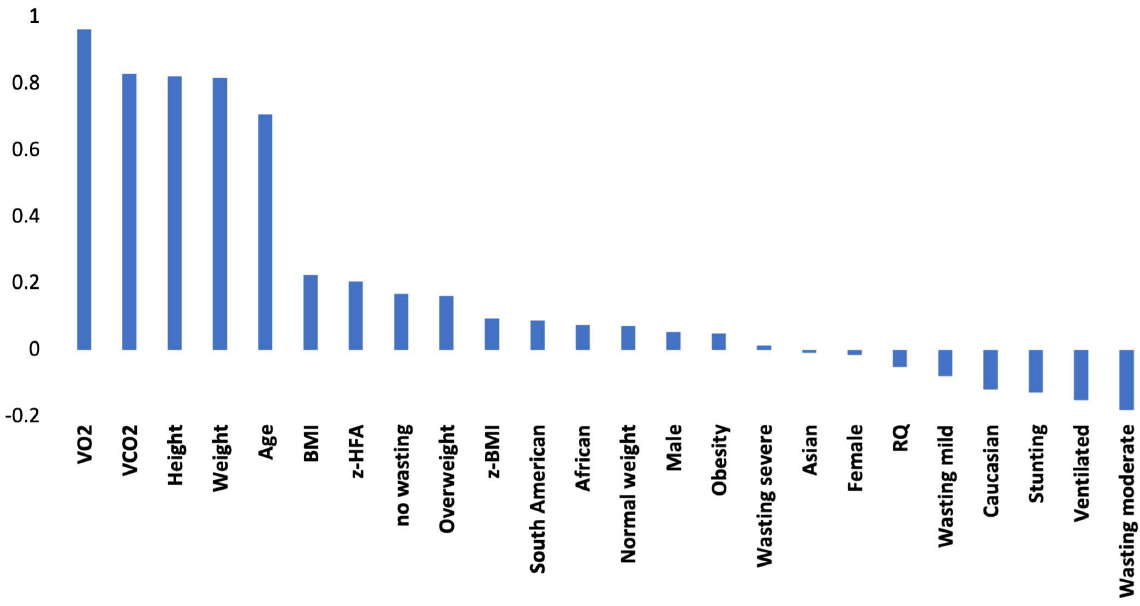
Figure 1. Correlations between the study variables and the REE value. Abbreviations: VO 2 = Oxygen Consumption; VCO 2 = Carbone Dioxide Production; RQ = Respiratory Quotient; BMI = Body Mass Index; z-BMI = z-score BMI; z-HFA = z-score Height for